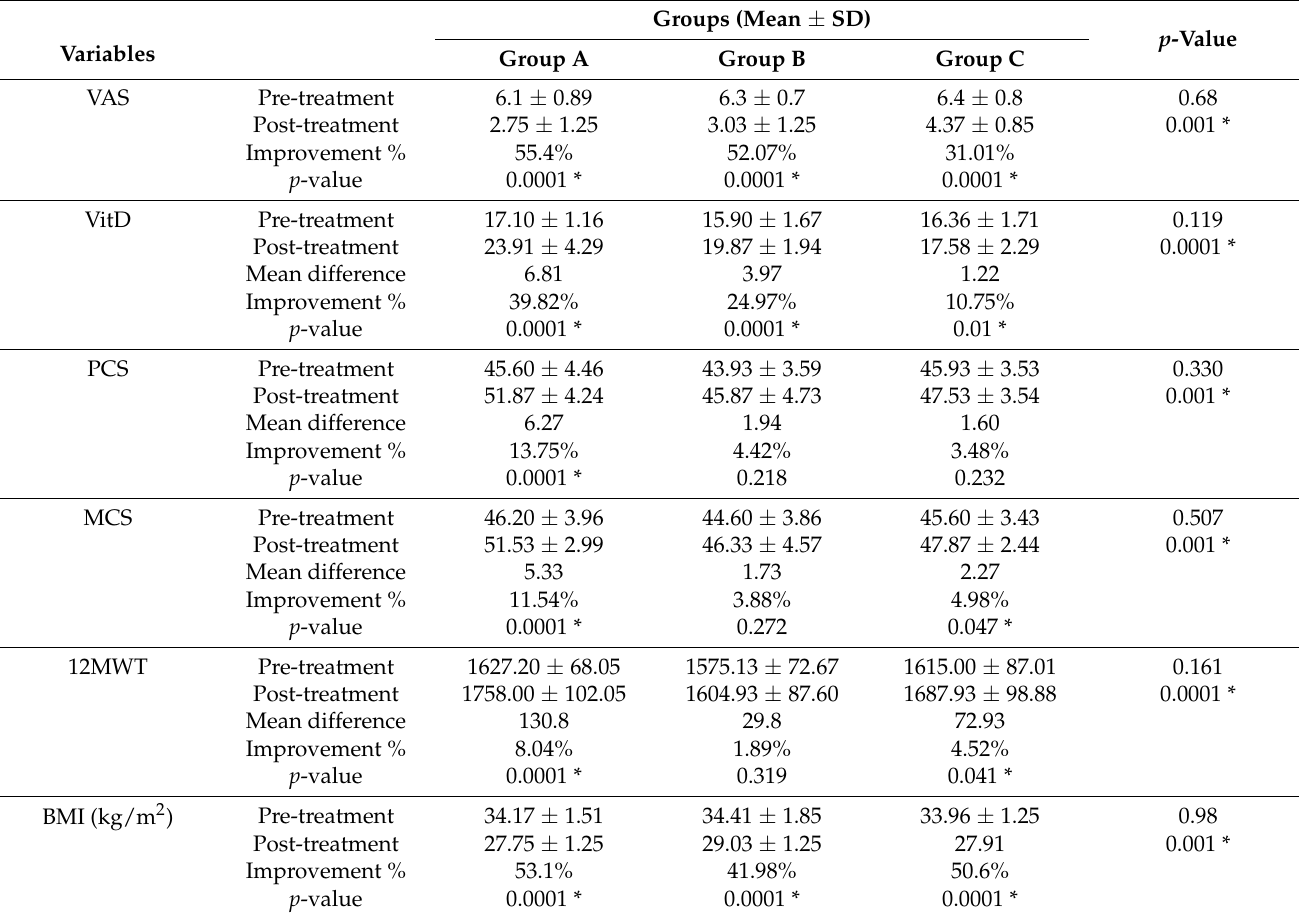
Table 2. Variables comparison within and among groups of the